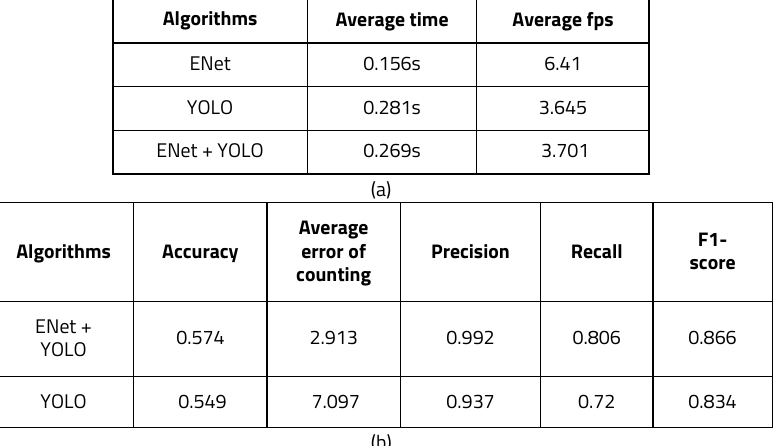
Figure 15. Time and accuracy measurement: ( a ) time and FPS measurement and ( b ) accuracy measurement.